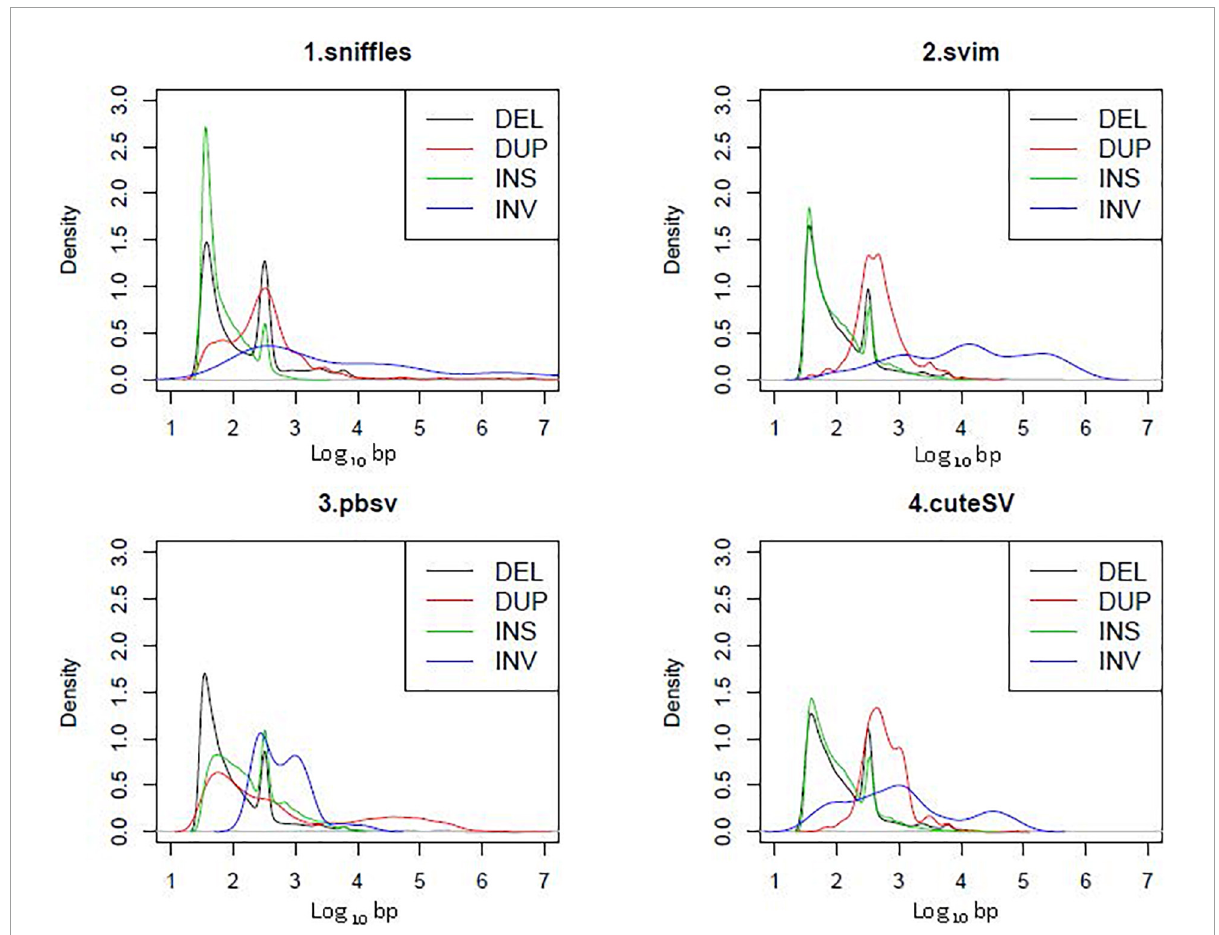
FIGURE4 Kernel density plot in length distribution of SVs from PacBio in 15